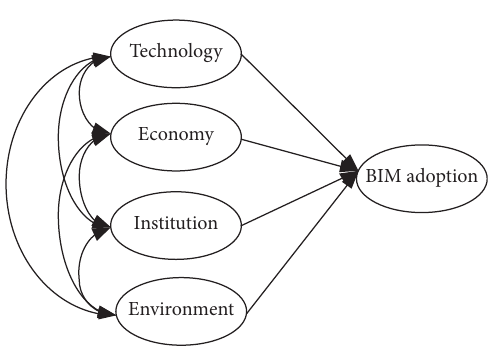
Figure 2: The conceptual